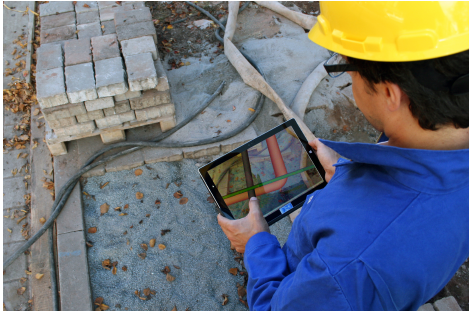
Figure 5: AR for utilities networks. Usage concept for the LARA